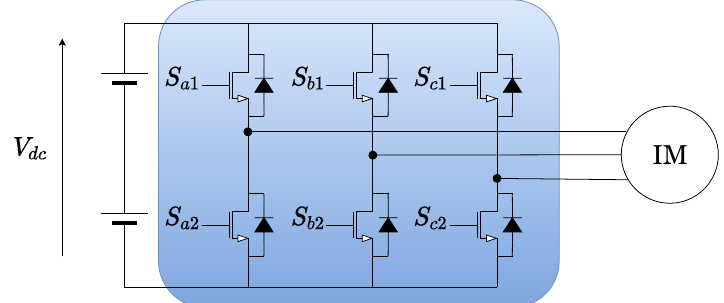
Figure 1. Simplified circuit of VSI converter supplying an